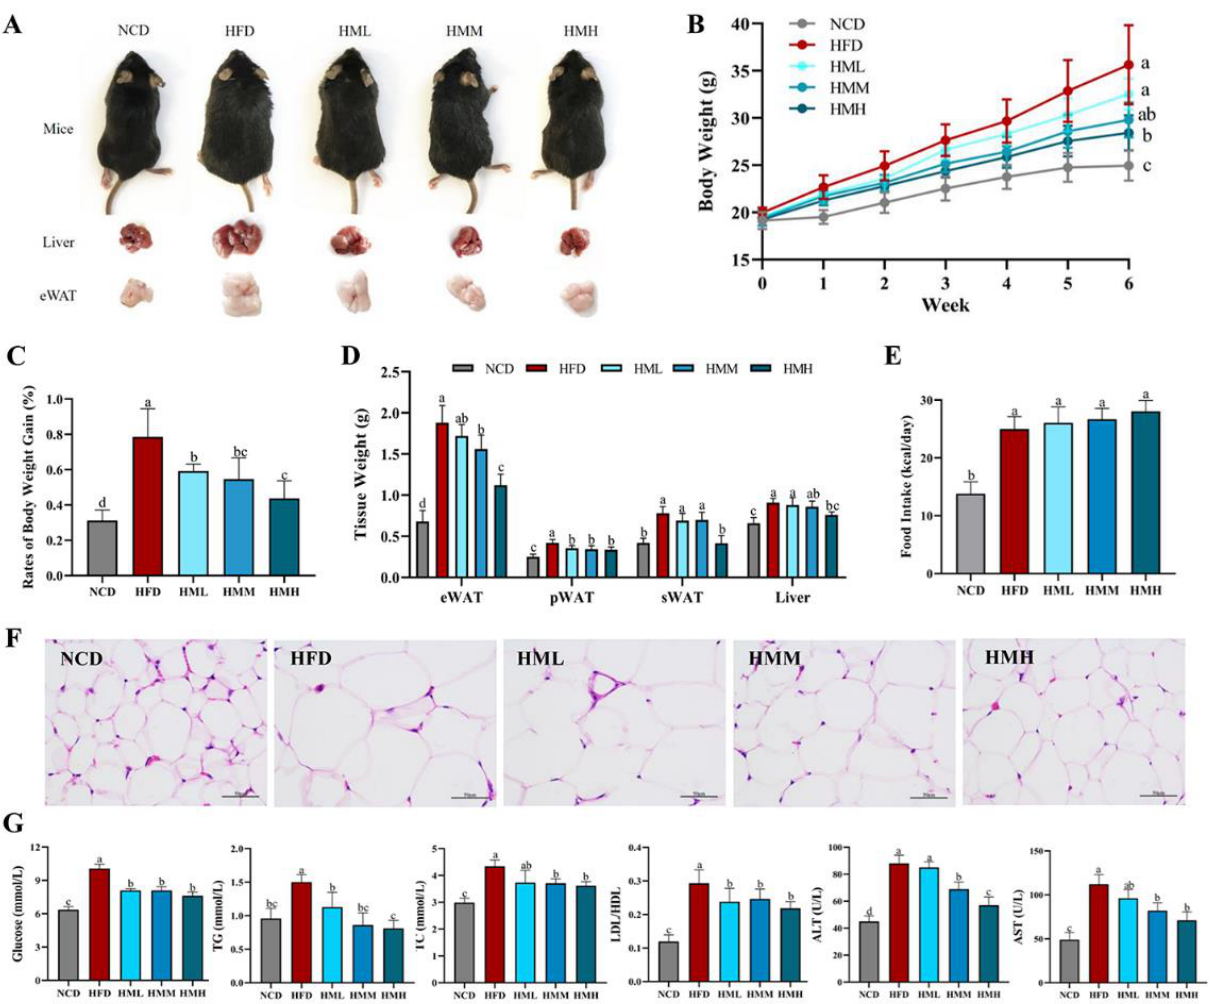
Figure 2. Effects of matcha on high-fat diet-induced obesity. ( A ) Representative images of the mice and tissues in different groups; ( B ) body weight evolution; ( C ) rates of body weight gain; ( D ) tissue weight; ( E ) food intake; ( F ) hematoxylin-eosin (H&E) staining of the epididymal adipose tissue; ( G ) serum biochemical parameters. Data are expressed as means ± SEM ( n = 5). Means with different letters (a–d) were considered significantly different at p < 0.05 according to Tukey’s test. NCD, mice on a normal chow diet; HFD, mice on a high-fat diet; HML, mice on a high-fat diet with 0.1% matcha; HMM, mice on a high-fat diet with 0.5% matcha; HMH, mice on a high-fat diet with 1.0% matcha.